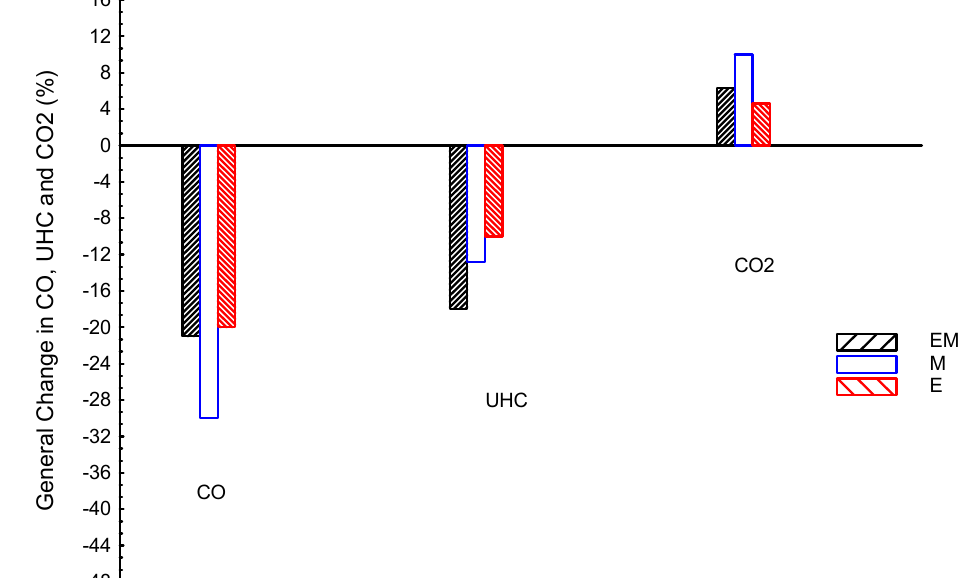
Figure 10. CO, CO 2 , and UHC emissions averages for ternary blended fuels of bio-ethanol–bio- methanol–gasoline (EM), bio-ethanol–gasoline (E), and bio-methanol–gasoline (M); gasoline is the reference line.